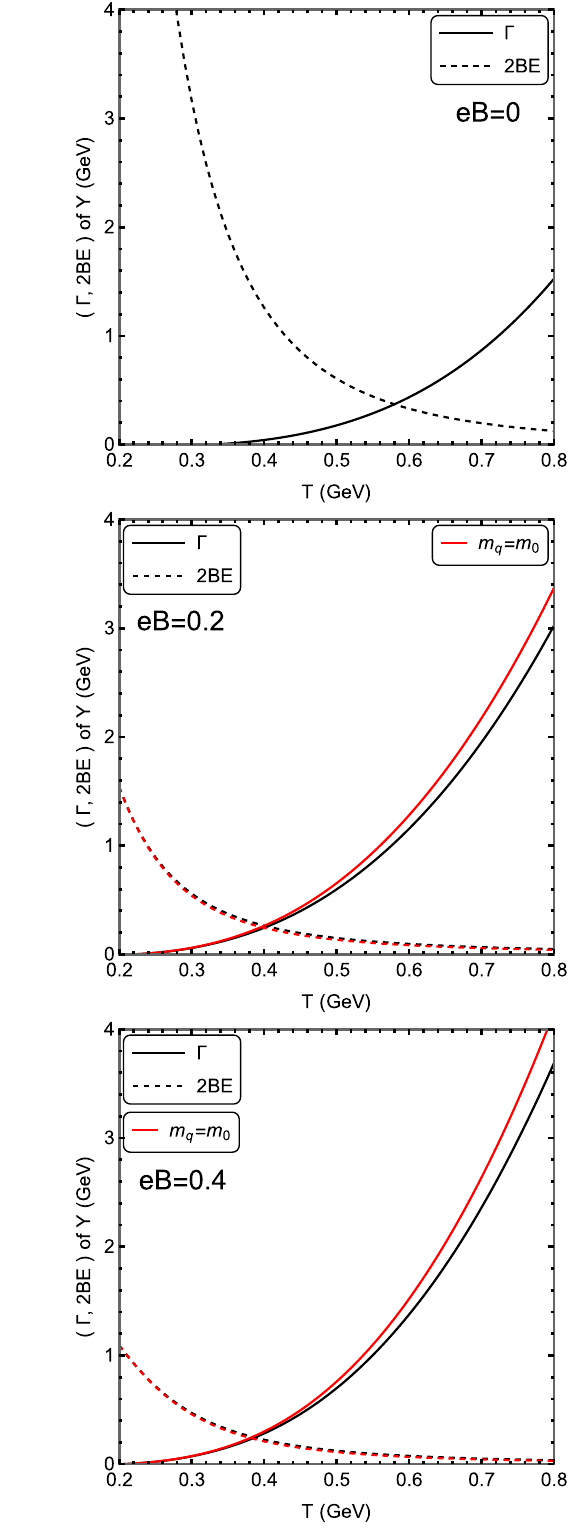
Fig. 7 Variation of (cid:15) , 2BE with temperature with different values of magnetic field (eB) for J /ψ